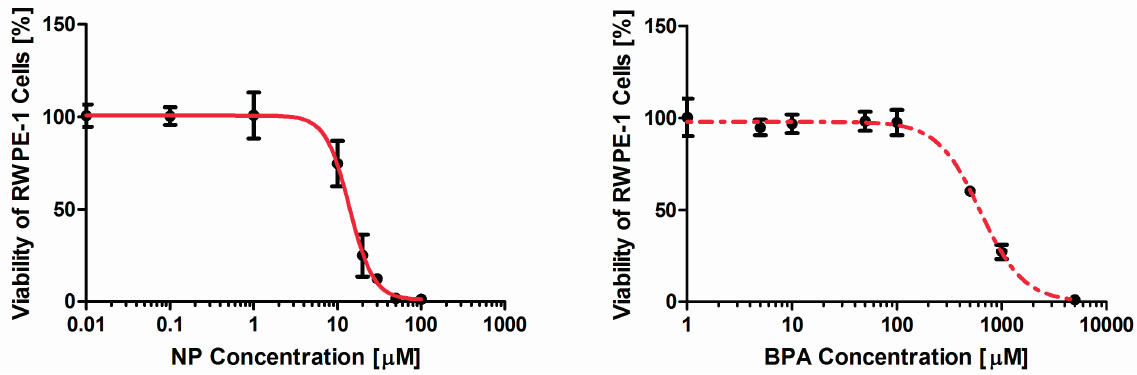
Figure 1. Concentration-response curves for NP and BPA on the cell viability of RWPE-1 cell regression from the Hill function. Experimental data are shown for at least three tested donors (each in